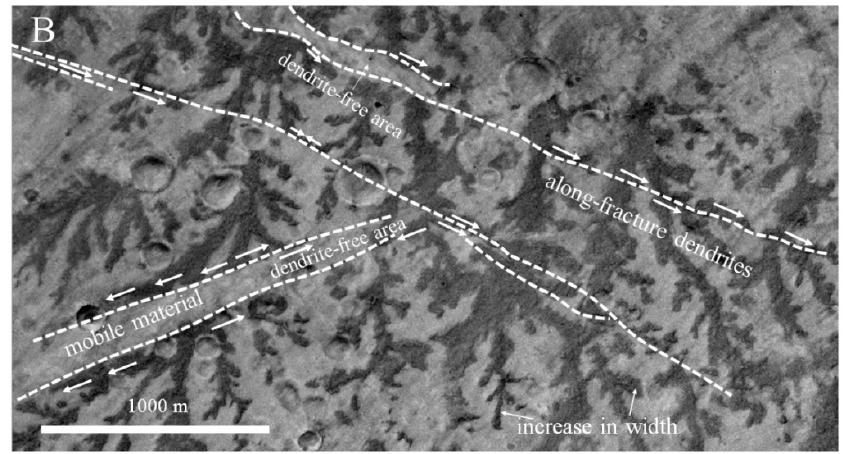
Figure 9. ( A ) Detail of the area marked with a white rectangle in Figure 6. ( B ) Interpreted image of the same area showing the faults, along-fracture dendritic growth, and dendrite-free spaces. CTX images. At the locations indicated with arrows, dendrites appear to follow the fracture (fault) lines, indicating the possibility that, after being separated by a fracture line, the dendrites subsequently propagated parallel to the fracture (“along-fracture dendrites” in Figure 9B).